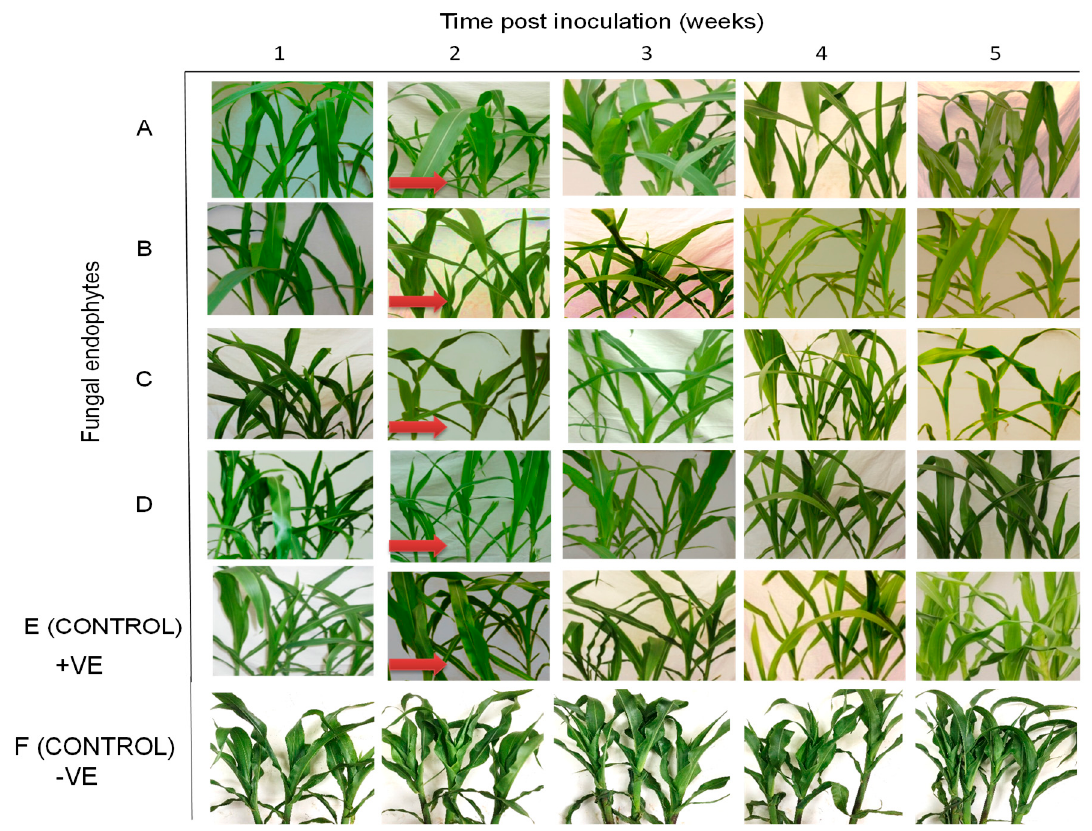
Figure 7. Disease symptom development in maize plants inoculated with fungal isolates, ( A ) ( Metarhizium anisopliae -ICIPE 69), ( B ) ( Trichoderma atroviride -F5S21), ( C ) ( Hypocrea lixii- F3ST1) and ( D ) ( Trichoderma harzianum -F2L4) following artificial inoculation with Maize chlorotic mottle virus . Panel ( E ) represents the positive control, where untreated maize plants were challenge-inoculated with SCMV, while ( F ) represents the negative control, where plants were neither treated with fungal endophytes nor challenge-inoculated with SCMV. The arrows indicate the onset of symptom expression in various treatments. Challenge-inoculation with MCMV was conducted 21 days after